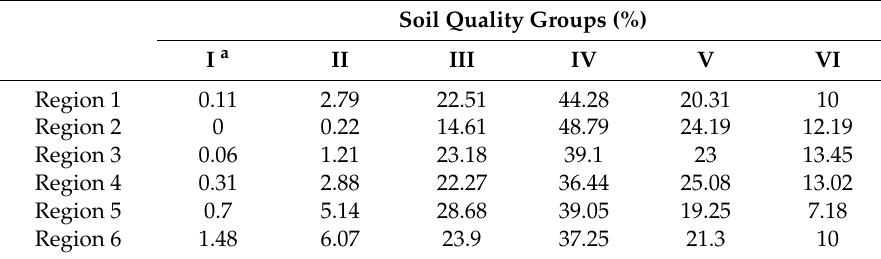
Table 2. Share of soil quality group in the total arable land in studied regions.